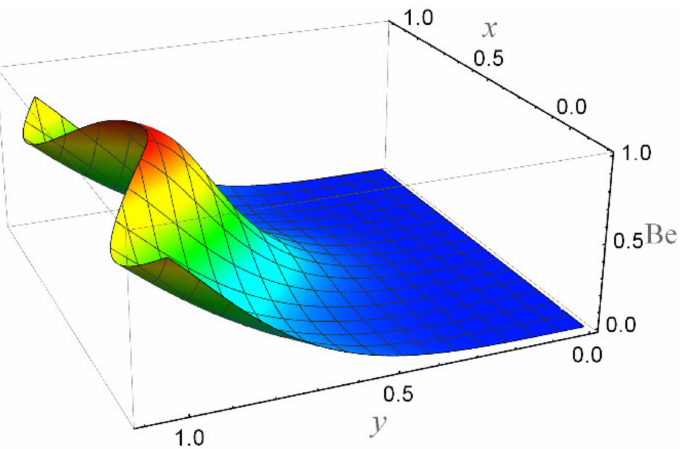
Figure 24. The Bejan number when Br = 5, ε = 0.2, α = 0.3, We = 0.01, β = 0.1, K = 2, R n = 3, Ha = 1, n = 0.2, and Ec =